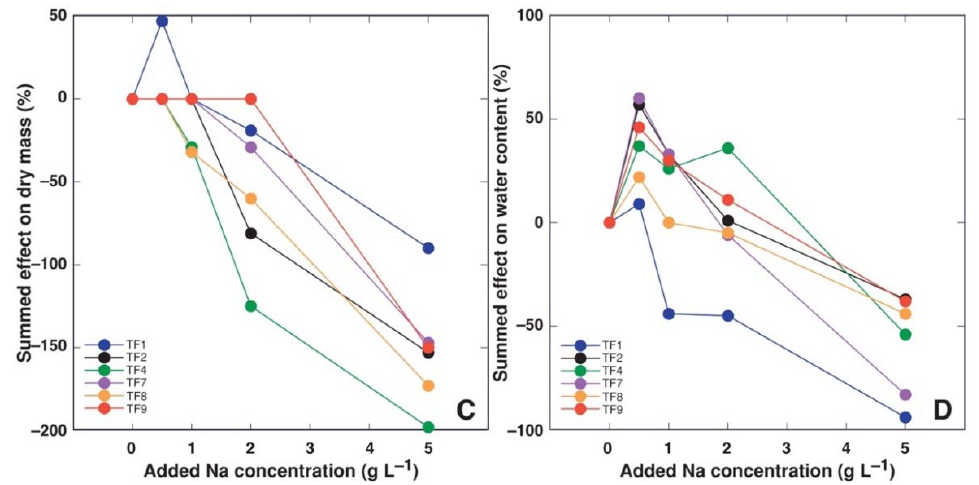
Figure 6. Summed relative effect of increasing substrate salinity on morphology ( A ), fresh mass of plant parts ( B ), dry mass of plant parts ( C ) and water content in plant parts ( D ) of Trifolium fragiferum plants of different accessions. Only statistically significant effects are taken into account.